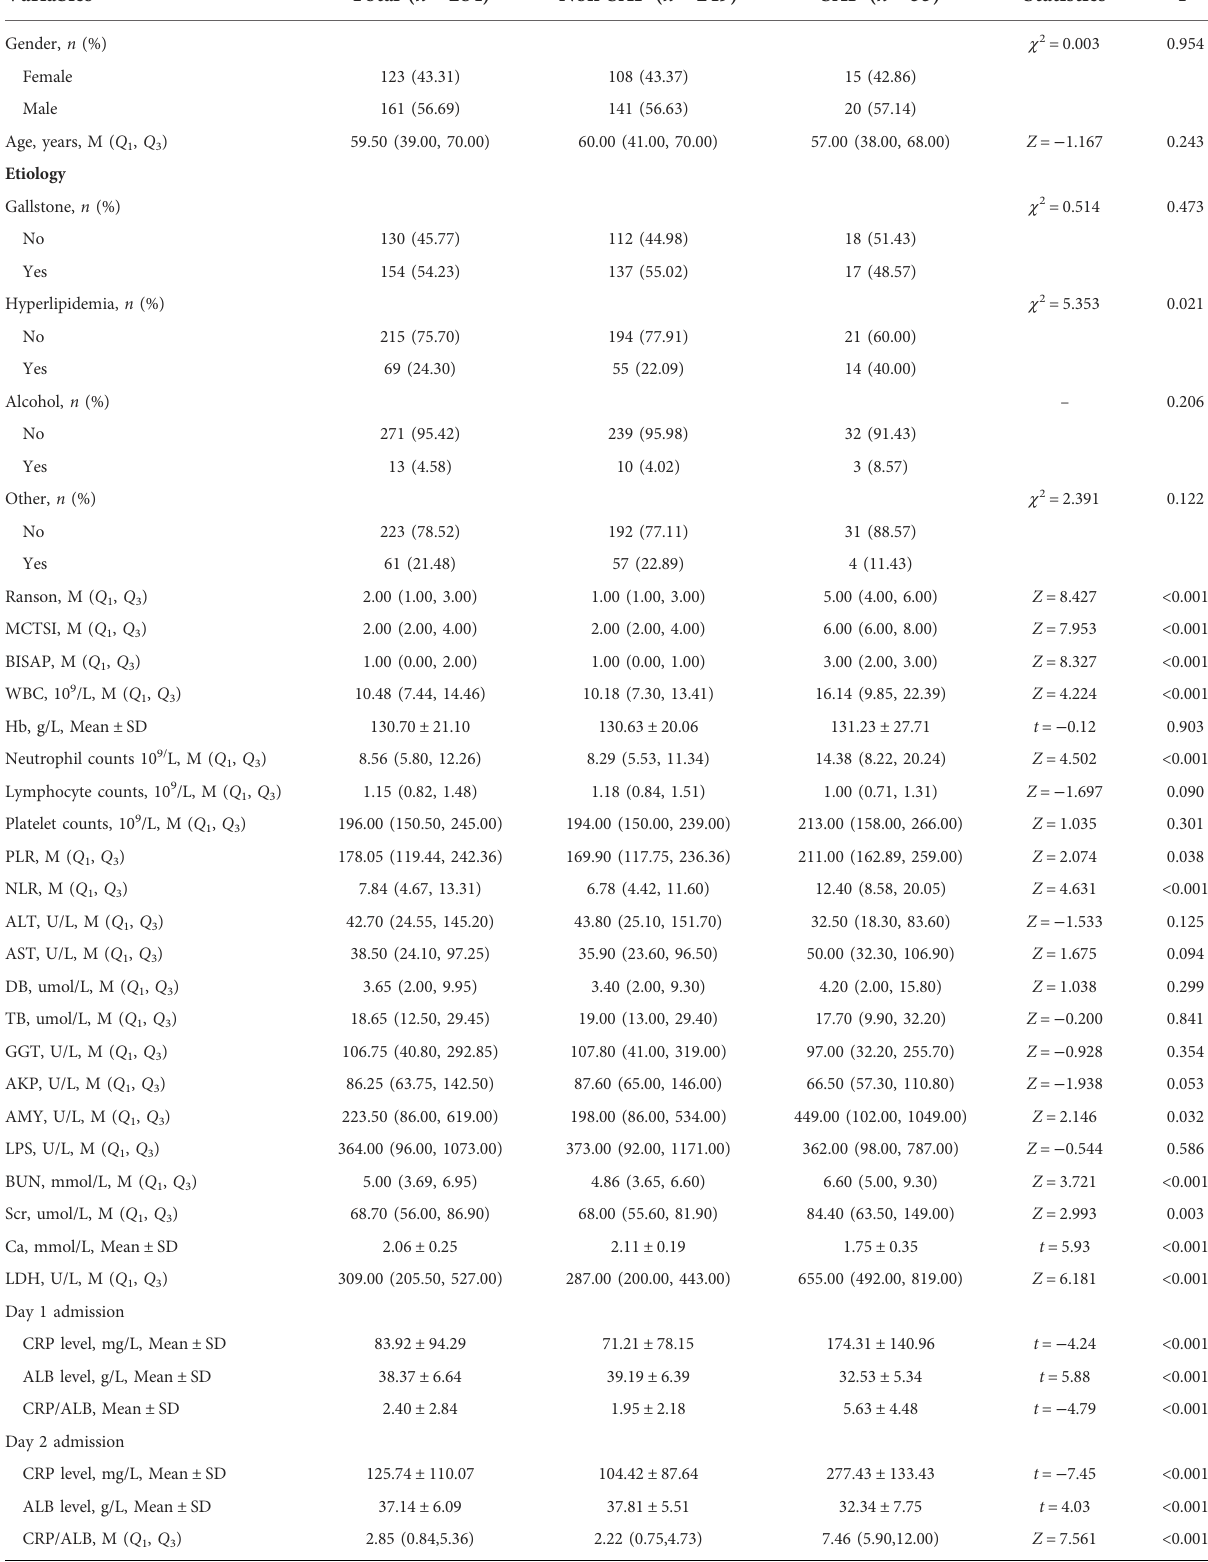
TABLE 1 Differences of population characteristics between patients with and without